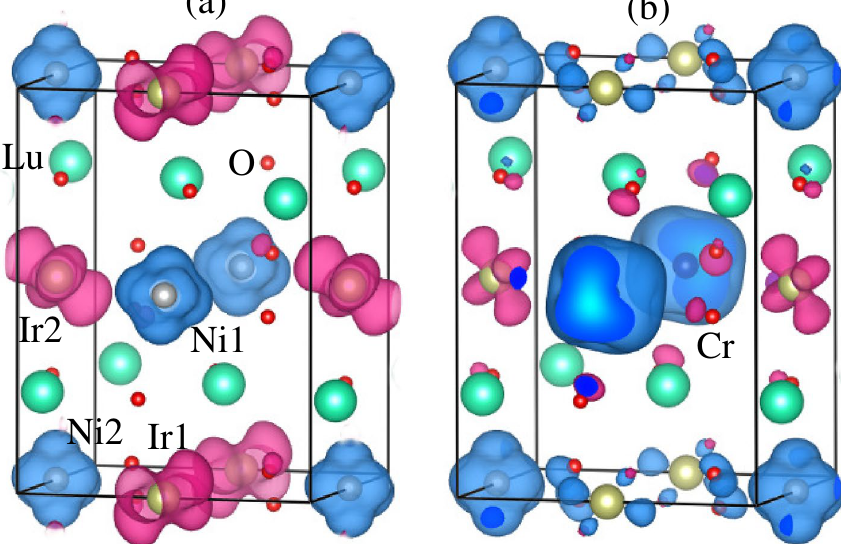
3 . The light blue and light pink colors represent